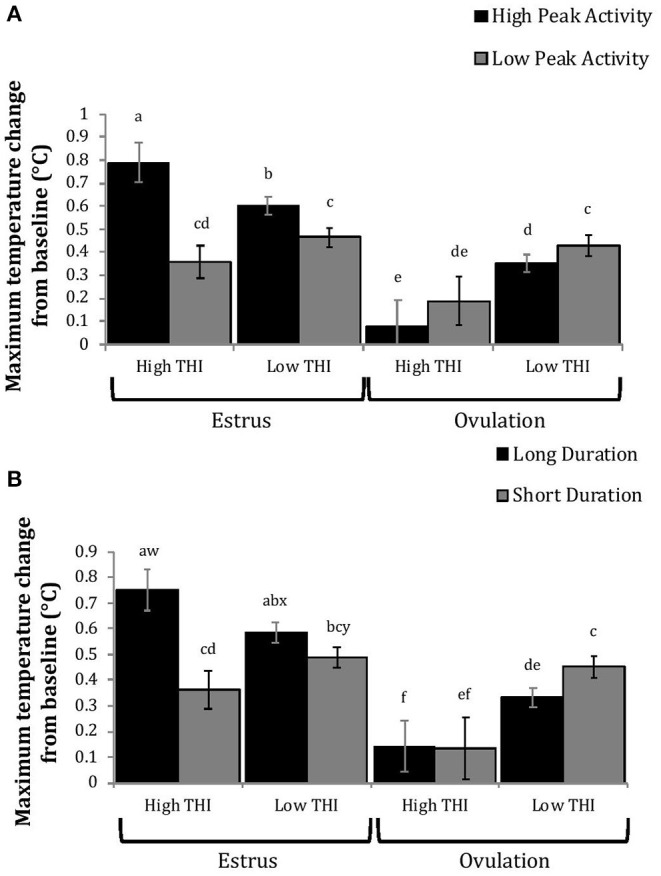
Maximum positive change in rumen-reticular temperature (least squared means ± SE) by sampling time (at the time of estrus or ovulation), THI and peak activity [(A); P < 0.01], or duration [(B); P < 0.01] obtained from a mixed linear regression model as described in Table 1. Superscripts of letters a-f denote significant differences (P < 0.05), while letters w-y denote tendencies (0.05 ≥ P < 0.10), between all groups of each panel. High peak activity: estrous expression greater than the median of 80 index on the AAM. Low peak activity: estrous expression less than the median. Long duration: estrous expression lasting longer than the median of 12 h. Short duration: estrous expression lasting less than the median. High THI: Maximum THI >72. Low THI: Maximum THI <72. THI data was collected relative to the sampling time (estrus vs. ovulation).